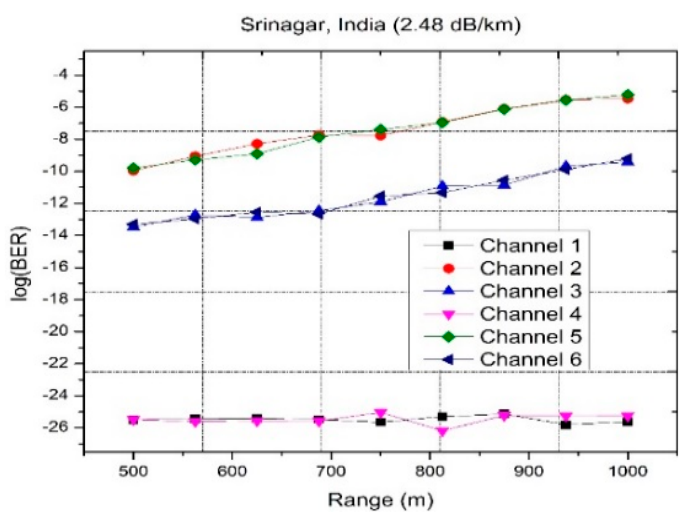
Figure 11. Log (BER) versus FSO link for Srinagar, India.